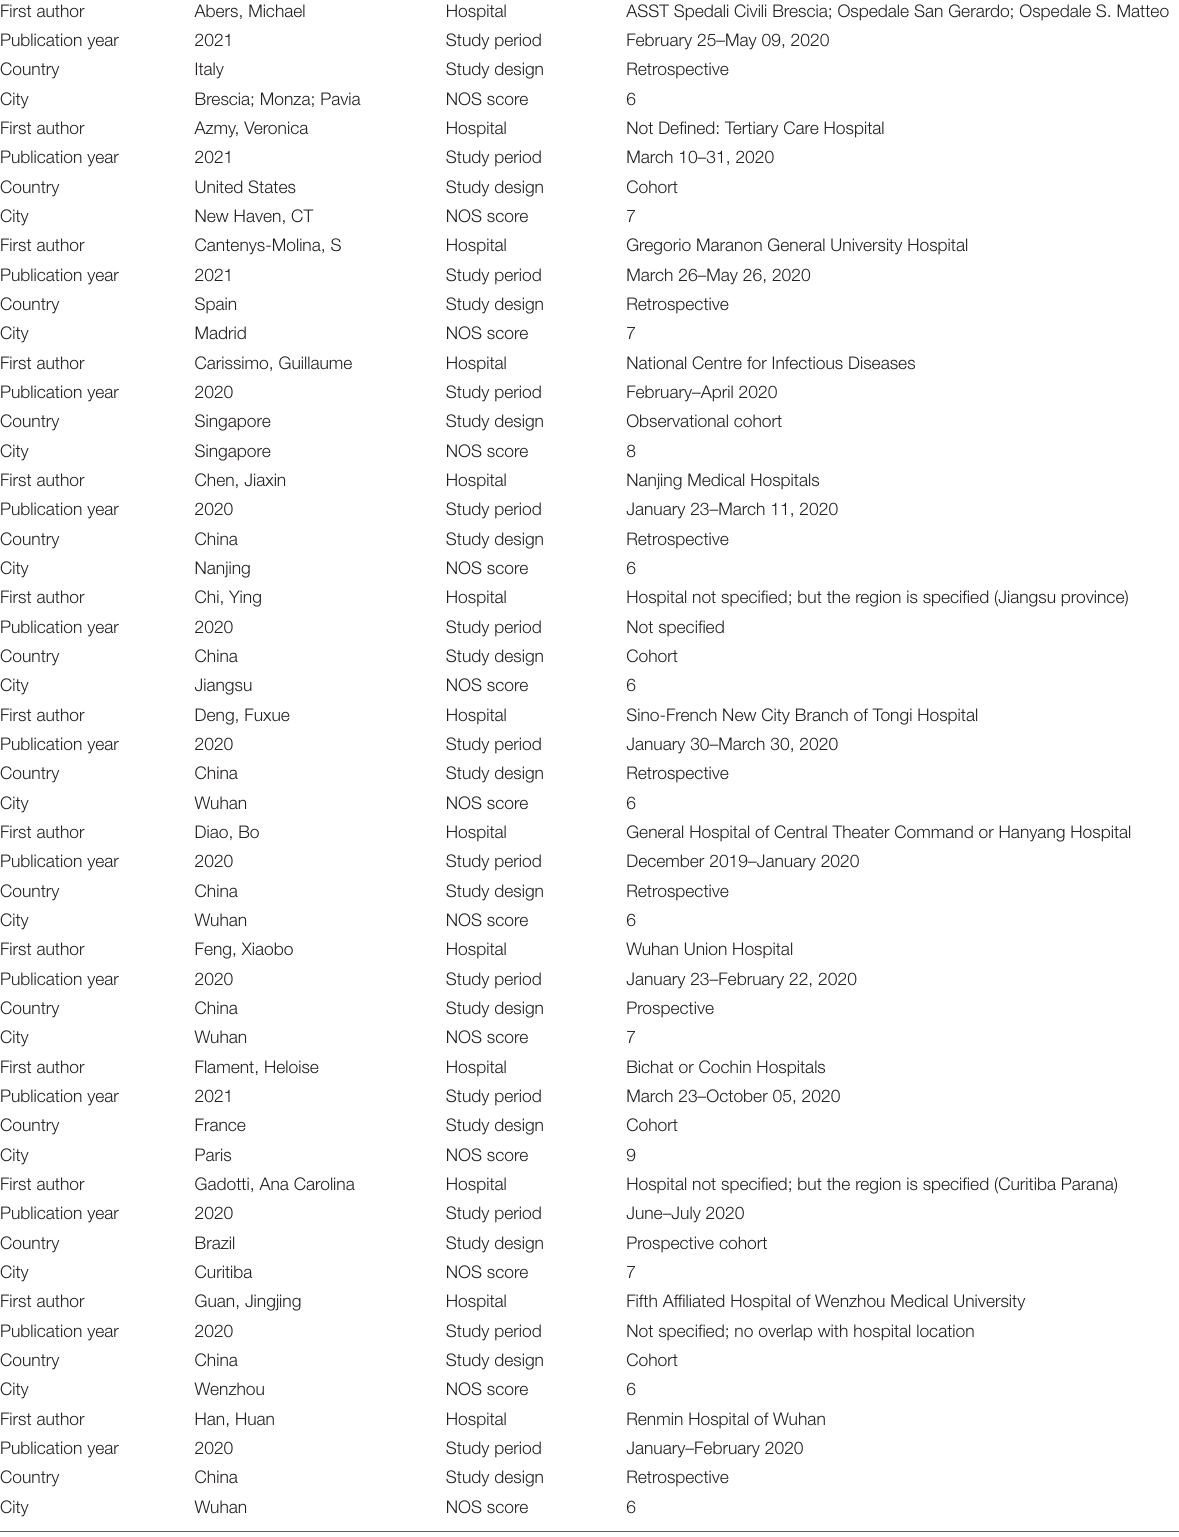
TABLE 1 | General characteristics of included